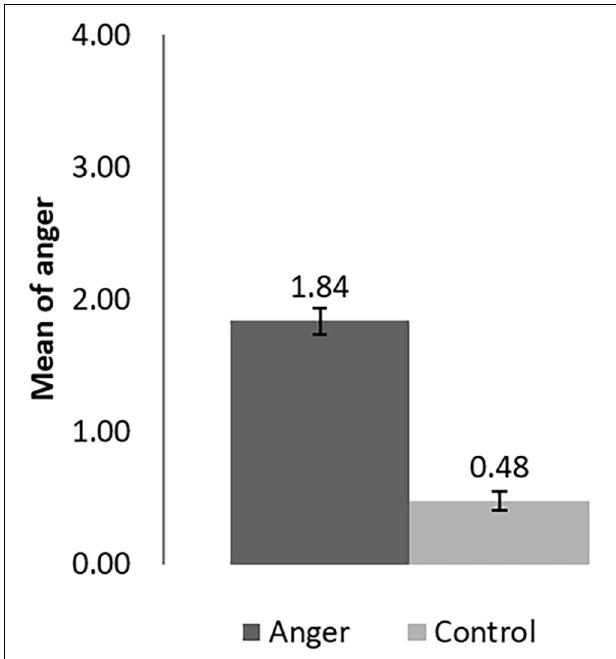
FIGURE 4 | Anger rating of the AEMT in the angry and control condition in Study 2. The error bar is the Standard error.